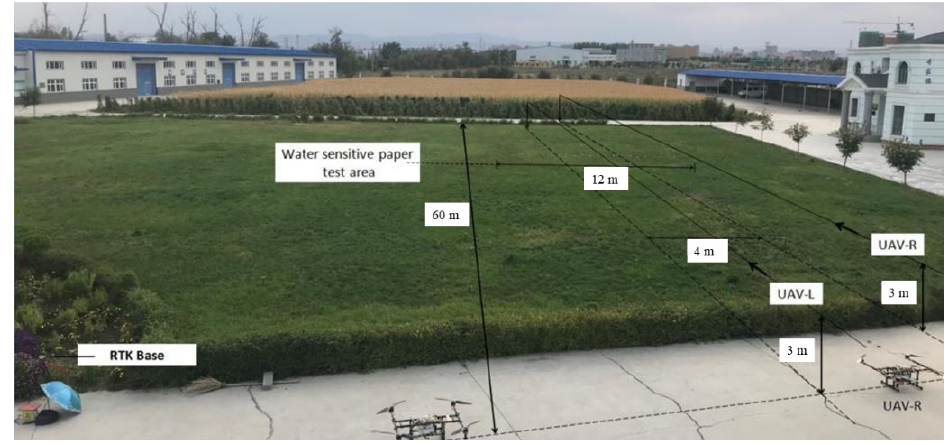
Figure 11. Testing area and experimental setup.